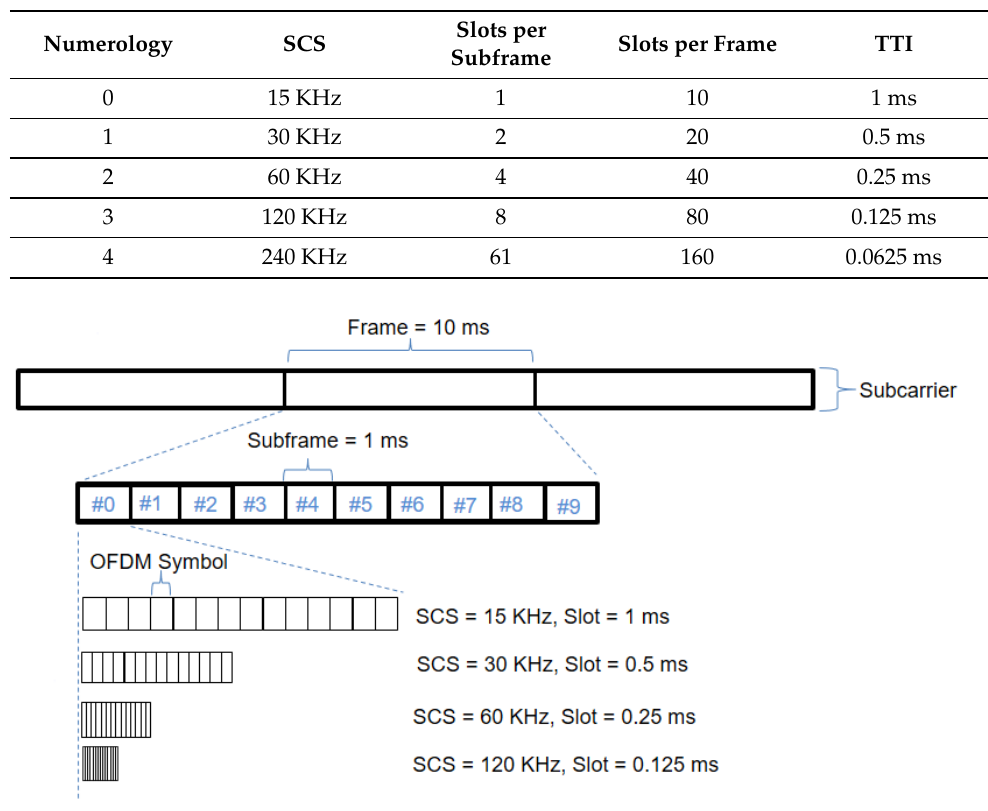
Figure 2. NR-V2X time–frequency